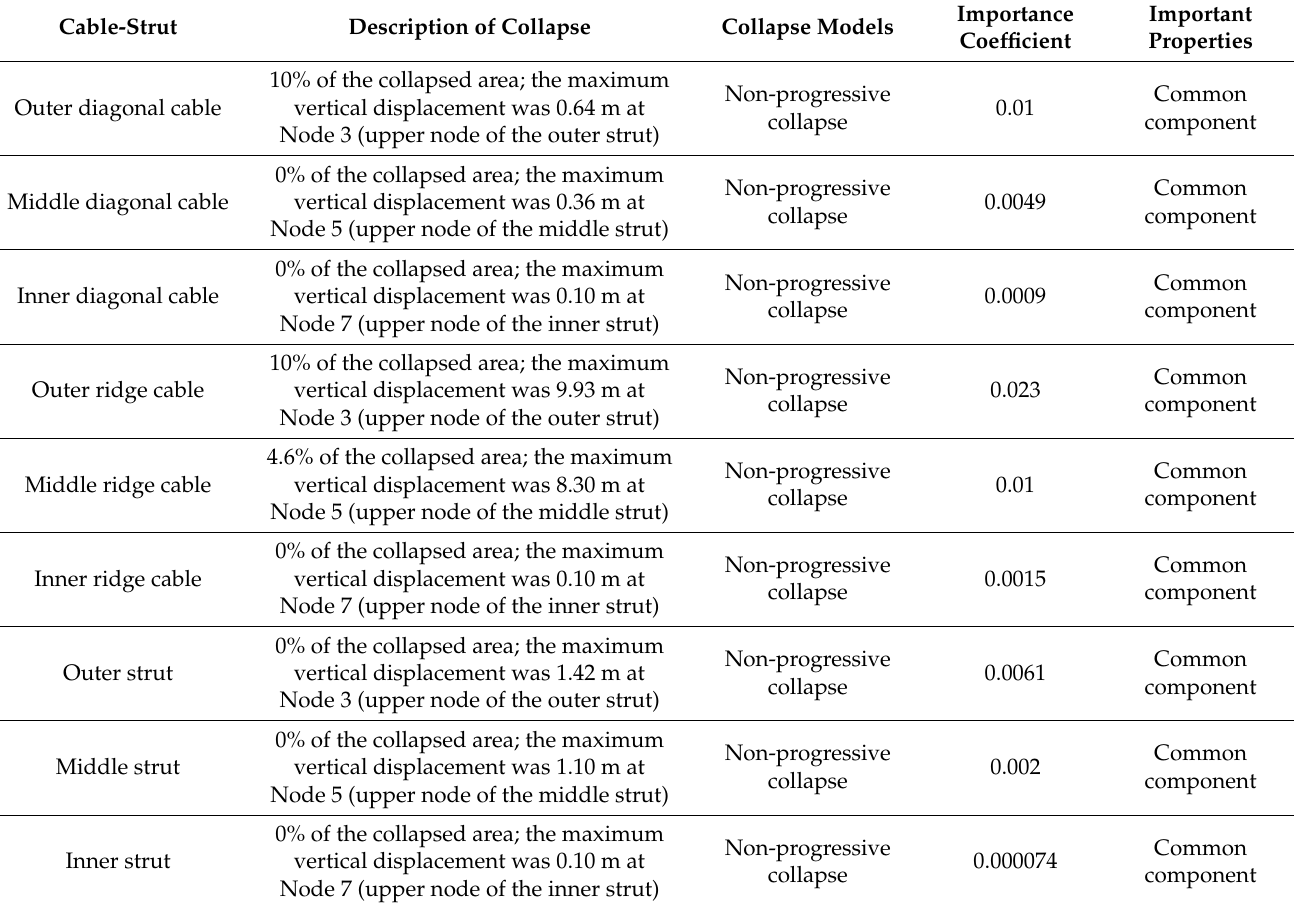
Table 2. Types of collapse induced by the removal of different types of Cable-Strut elements and the importance categories of these